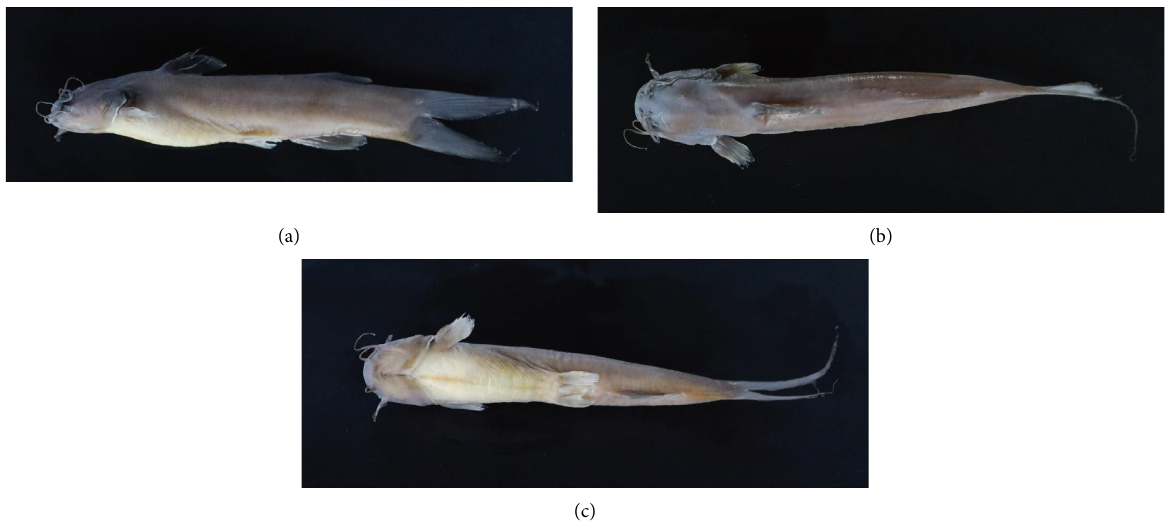
Figure 2: (a): Lateral view, (b) dorsal view, and (c) ventral view of A. waikhomi.